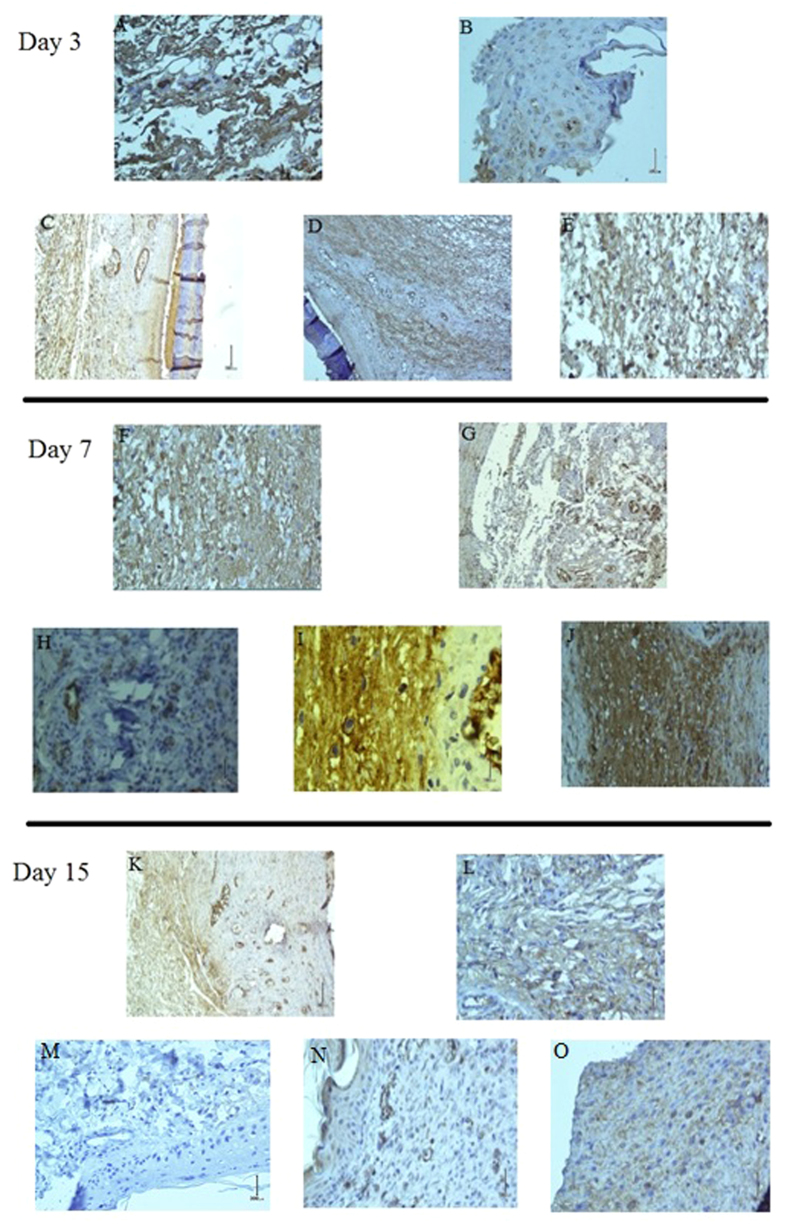
Tissue sections were immnunohistochemically stained with TGF-β1 antibody and showed with contrast against the background.(A–E) Day 3, (F–J) day 7, (K–O) Day 15. The magnification of the images are 40X. For each day, Top row from left to right :non diabetic-control & non diabetic-plasma treatment. Bottom row from left to right: diabetic-control, diabetic-helium gas treatment & diabetic-plasma treatment.